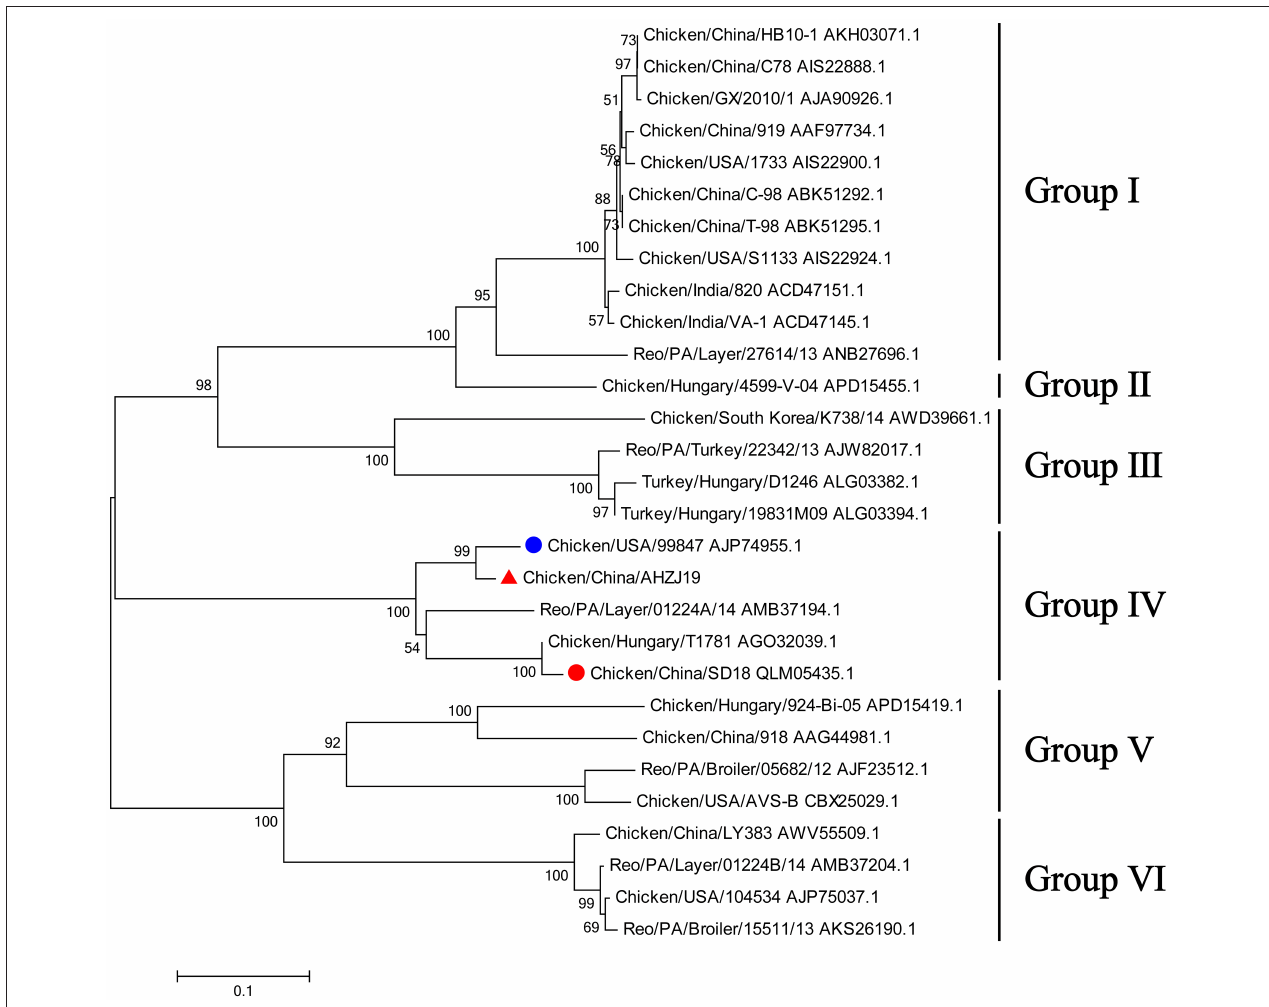
FIGURE 2 | Phylogenetic tree of AHZJ19 and reference strains based on aa sequences of σ C protein. The phylogenetic tree was constructed using the neighbor-joining method (1,000 bootstraps) with MEGA6. The AHZJ19 strain isolated in Anhui in 2019 is indicated by the red triangle. The strain sharing the highest homology with AHZJ19 in the world and in China is indicated by the blue and red circle,